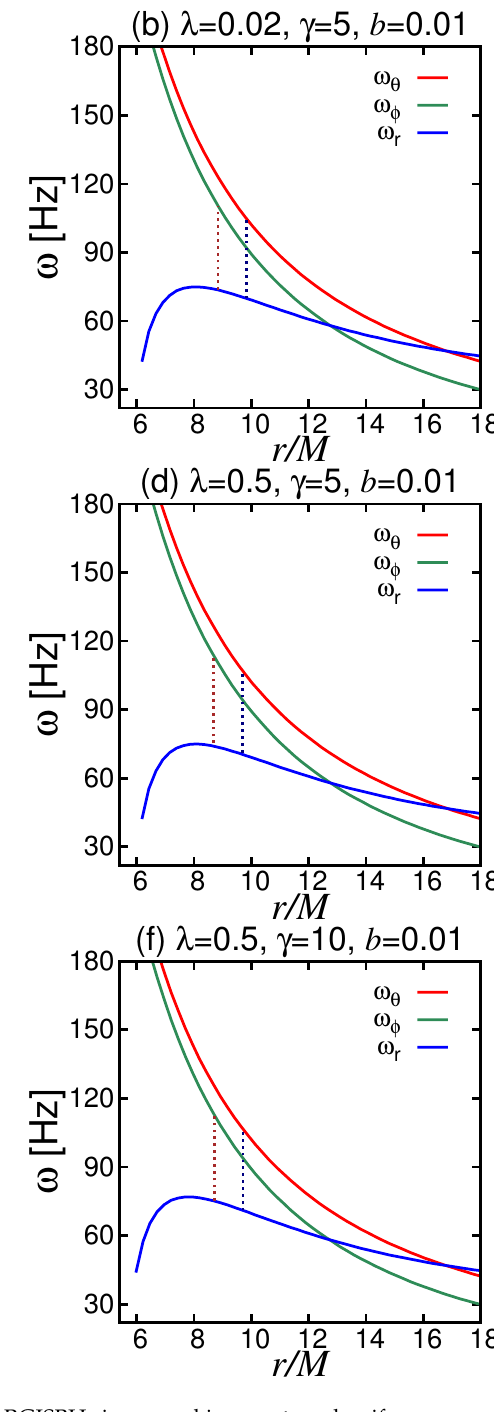
Figure 9. The epicyclic frequencies for RGISBHs immersed in an external uniform magnetic field by taking M / M (cid:12) = 10. Blue dotted vertical lines denote the positions of the 3:2 resonance between ω θ and ω r and brown dotted vertical lines denote the ones between ω φ and ω r